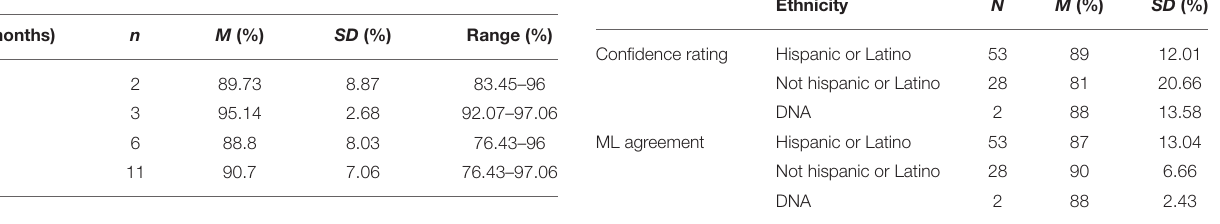
FIGURE 8 | Participant C (at-home). Example of a 72-month-old child that OpenFace may have trouble identifying all components due to the fact that the video did not capture all of the child’s face. TABLE 2 | Online ML agreement without participant C.